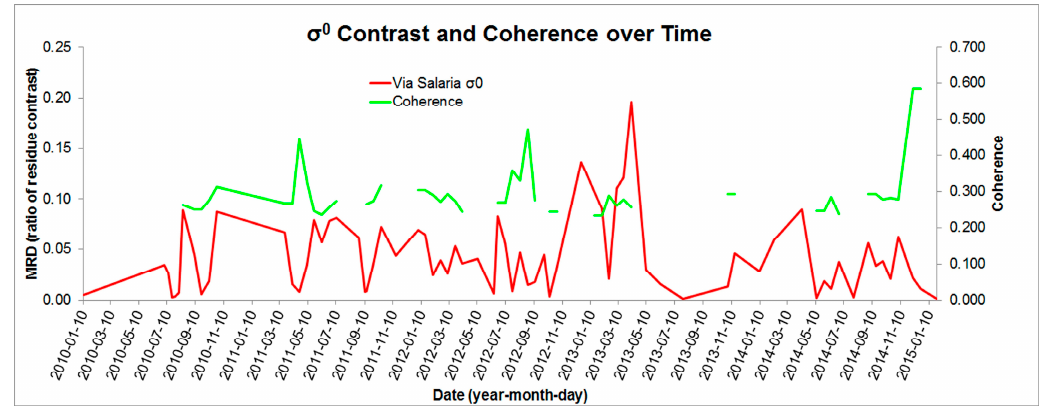
Figure 52. Graph showing clarity (contrast) of the residue of the ancient Via Salaria (in red), plotted over time and with residue coherence (in green). The clarity of residues is quantified as a ratio (MRD).